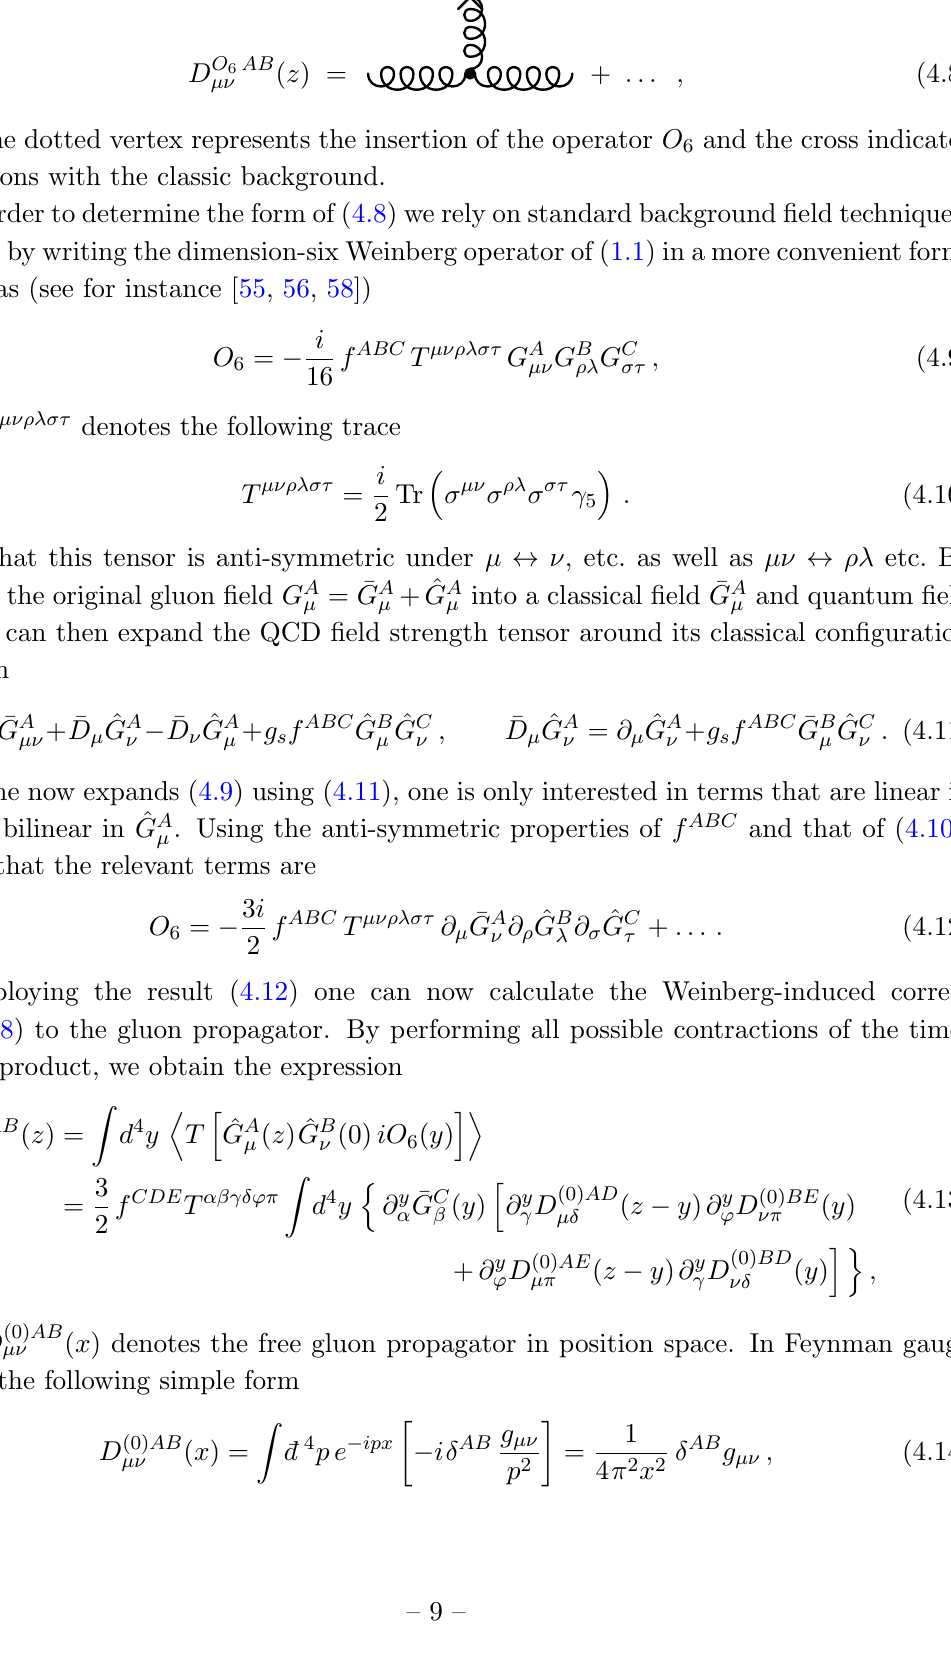
Figure 2 . Contribution of the dimension-six Weinberg operator to the quark propagator. The dotted vertex represents the operator insertion, the crosses indicate interactions with the background and the solid lines depict quark propagators. where C k are so-called Wilson coe  cients and h Q k i = h ⌦ | Q k | ⌦ i are vacuum matrix elements or condensates of the operator Q k . One important ingredient to evaluate (4.3) is the quark propagator on the CP-conserving back- ground including insertions of the EM field and O 6 . In position space and suppressing colour and spinor indices the sought propagator reads S ( x ) = S (0) ( x ) + S q ( x ) + S O 6 ( x ) , (4.4) where the first term is the free propagator for a massless quark and the second term describes non-perturbative interactions with background quark fields. As shown in Appendix C at leading order (LO) in the OPE these two quantities take the following form S (0) ( x )